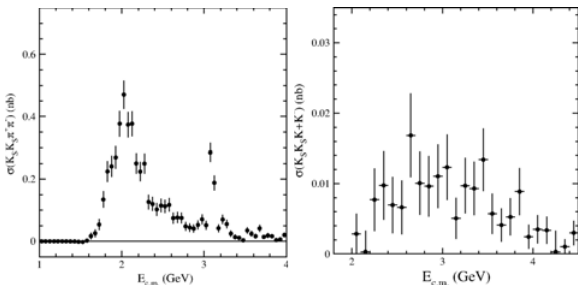
Figure 7. The e + e − → K 0 S K 0 S π + π − and K 0 S K 0 S K + K − hadronic cross sections at B A B AR . In the left plot the J /ψ peak is visible. In the right plot the J /ψ has been